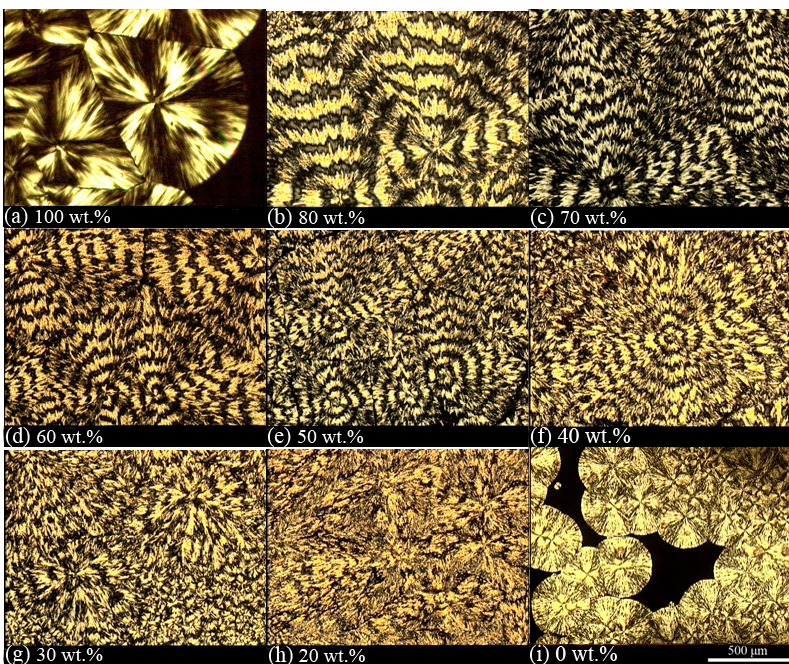
Figure 6. Polarized optical micrographs of 3- μ m-thick films: ( a ) poly( L -lactic acid) (PLLA) and ( b – h ) PLLA/poly(ethylene oxide) (PEO) blend films sandwiched between two glass slides after annealing in air at 125 °C for five hours for different PLLA weight concentrations; ( i ) a PEO film sandwiched between two glass slides after annealing in air at 50 °C for two minutes [42].